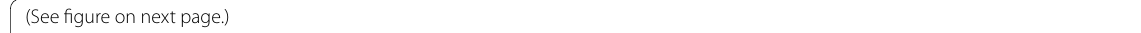
Fig. 2 The behavioral performance in mice. A , D During phase 1, there was no significant difference between the two sides in all groups. B , E During phase 2, all of the mice preferred to stay with the stranger mouse. C , F During phase 3, WT RA, SMND-309 and SMND-309 CIH mice + + preferred to stay with Stranger 2 than with Stranger 1 (p < 0.05). However, WT CIH mice spent a similar amount of time with each of the two + stranger mice (p > 0.05). G The mean escape latencies of the four groups. H The total swimming distances among all groups were similar (p > 0.05). I The time the WT CIH mice spent in the target quadrant was much shorter than the time the WT RA mice spent (p < 0.05), and this was + + improved by SMND-309 treatment (p < 0.05). J WT RA mice traveled longer distances in the target quadrant than the WT CIH mice (p < 0.05), + + and after SMND-309 treatment, the damage was improved (p < 0.05). K The number of platform crossings of WT CIH mice was less than WT RA + + mice (p < 0.05), but it was improved by treating with SMND-309 (p < 0.05). L , M The fear memory was damaged by CIH exposure, and SMND-309 alleviated the damage. *p < 0.05 Stranger 1 vs. empty cage. *p < 0.05 Stranger 1 vs. Stranger 2. *p < 0.05 WT group vs. WT CIH group. **p < 0.05 WT CIH group vs. SMND-309 CIH group. N 10 for each group. Data are shown as the mean SEM. The results of social tests were analyzed by one-way = ± ANOVA and a Bonferroni test. The results of escape latency were checked by three-way mixed ANOVA. Others were measured by